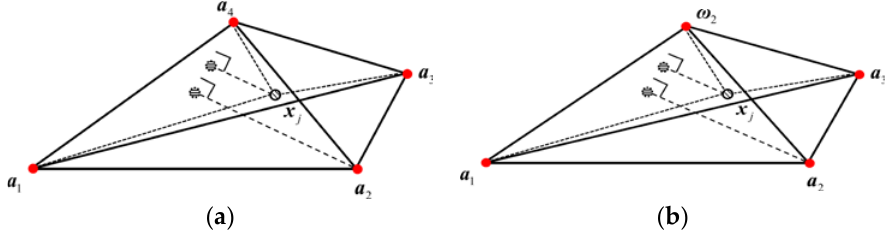
Figure 8. Diagram of geometric projection onto hyperplanes. ( a ) LMM; ( b ) bilinear mixture models (BMMs).